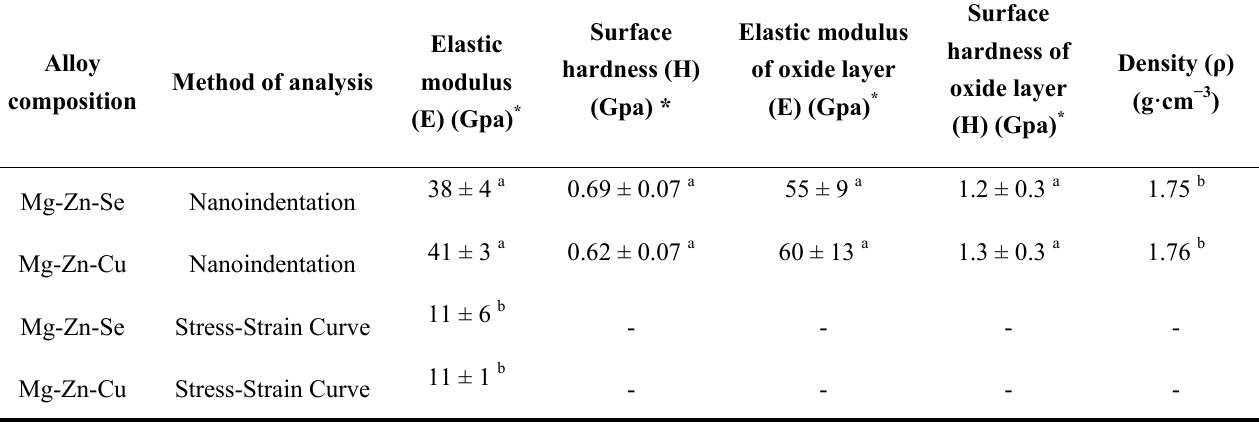
Table 1. Mechanical properties of ternary magnesium